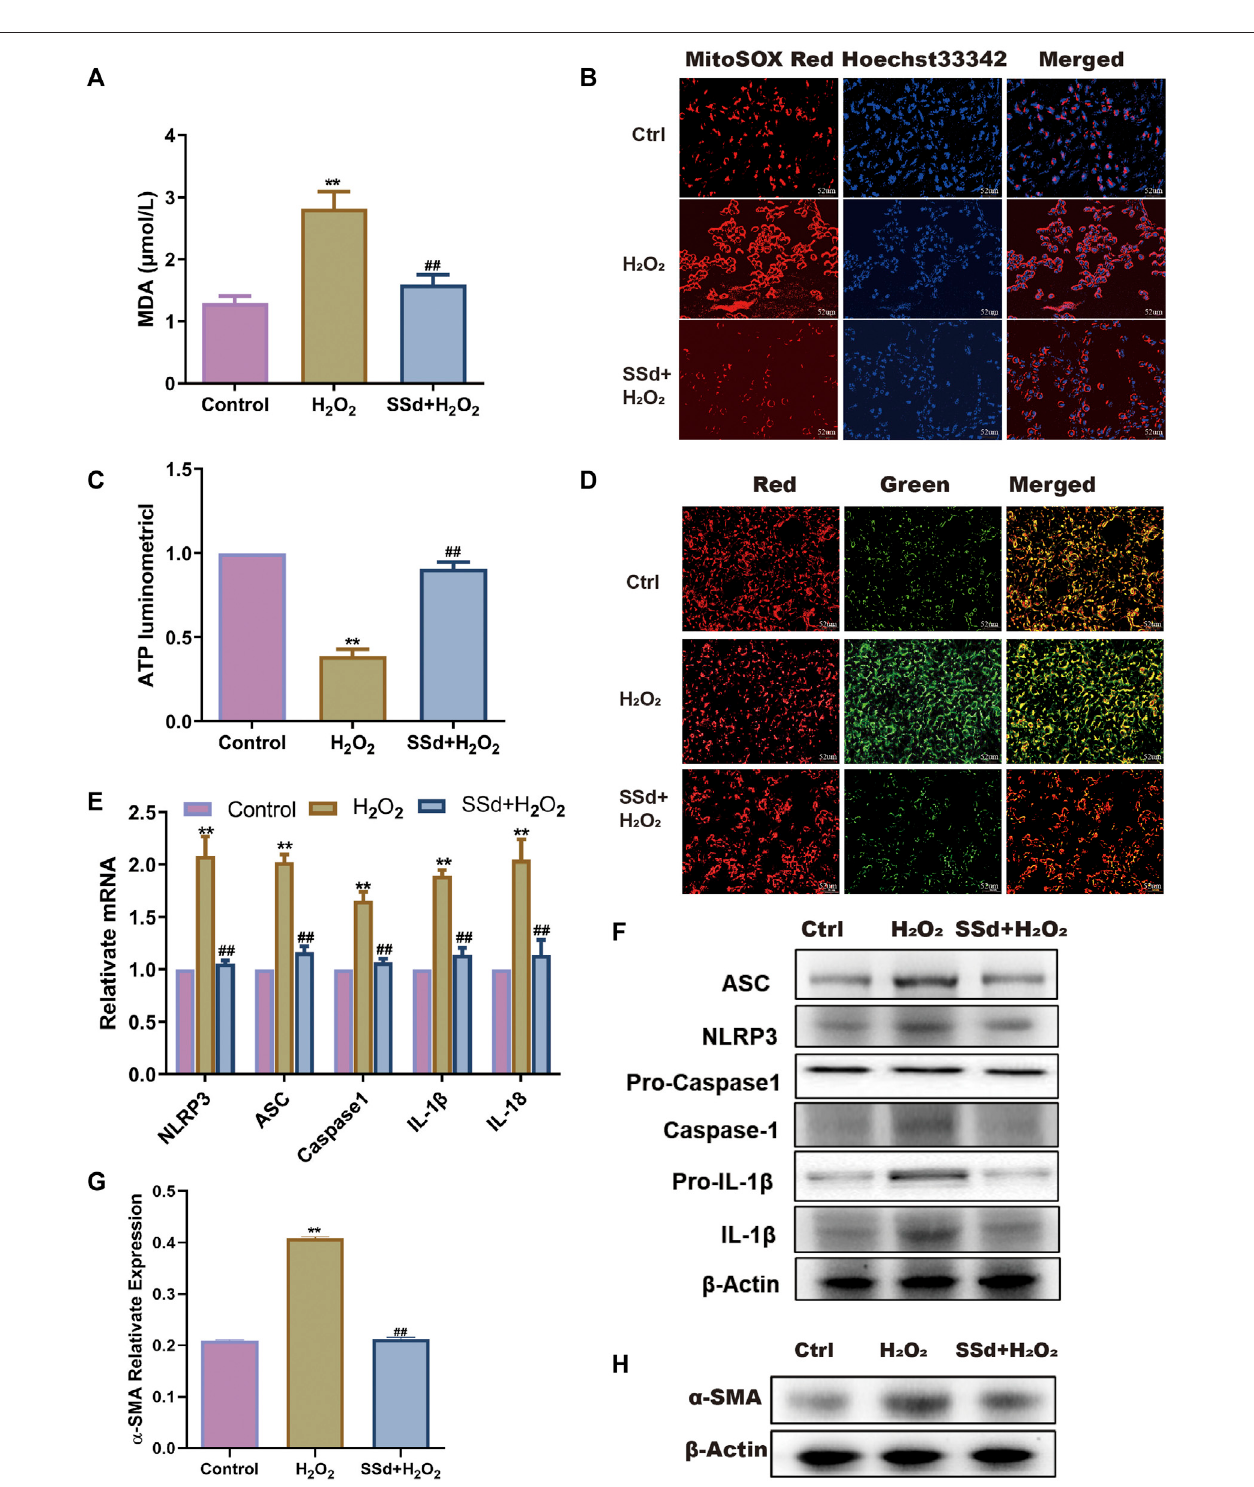
FIGURE 3 | SSd alleviated H 2 O 2 -induced mitochondrial dysfunction and NLRP3 activation in HSCs (A) the content of MDA in HSCs after SSd intervention combination with H 2 O 2 or not, n = 6. (B) MitoSOX Red fl uorescence images (the heavier the red, the more damage, scale bar, 52 μ m). (C) ATP content, shows the degree of damage to mitochondria in HSCs, n = 6. (D) JC-1 fl uorescence images (the more JC-1 monomers with green, the more damage to mitochondria, scale bar, 52 μ m). (E,F) RT-PCR and WB was employed to examine the expression of in fl ammasome, n = 3. (G,H) α -SMA protein expression, n = 3. Data are expressed in mean ± SEM; ** p < 0.01, H 2 O 2 treated group versus control group; ## p < 0.01, H 2 O 2 +SSd group versus H 2 O 2 treated group.